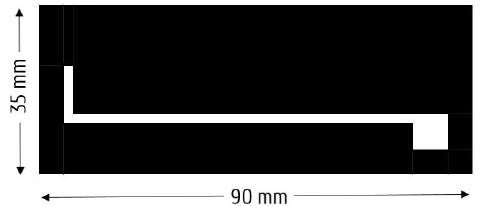
Figure 1. Design of the sputter mask used for pattering the thermocouple leg. The mask is fabricated out of stainless steel and has a thickness of 0.5